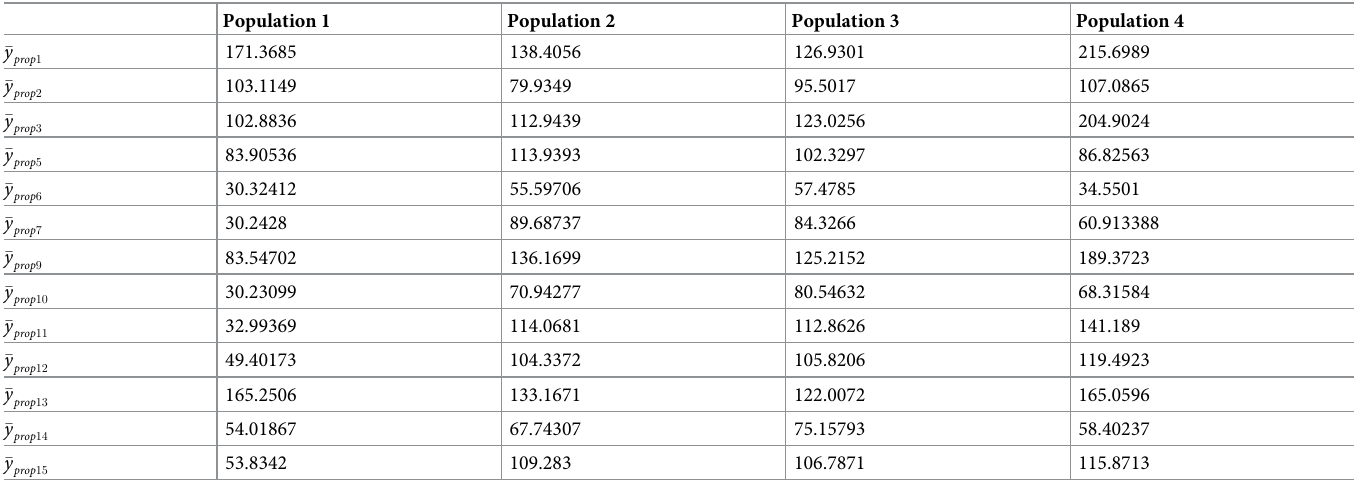
Table 3. Percentage relative efficiency of proposed family